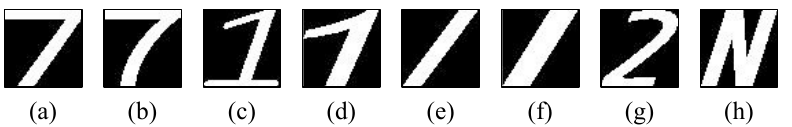
Figure 13. Some images taken from the testing data set that led to misclassifications: ( a , b ) are class ‘7’,